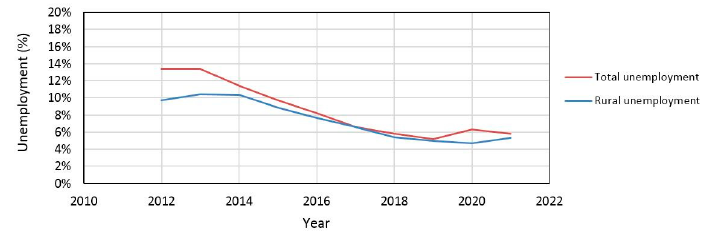
Figure 19. Registered total and rural unemployment in Poland, data obtained from [66].